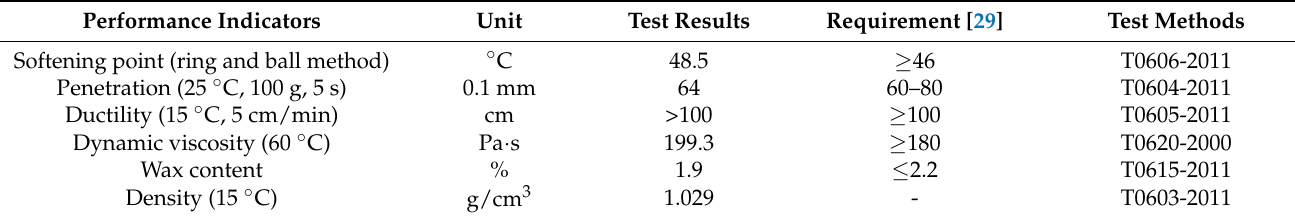
Table 1. Performance indicators of A-70 petroleum asphalt.